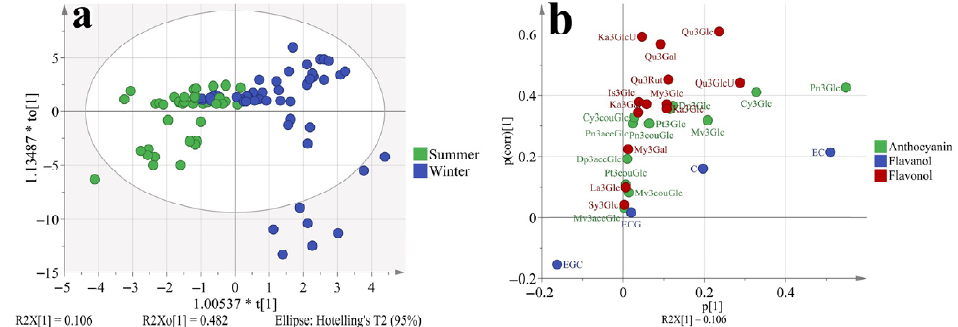
Figure 5. OPLS-DA ( a , score plot; b , S-plot) based on the concentration of individual phenolic compounds in ‘Muscat Hamburg’ grapes and ‘Victoria’ grapes in the years of 2014 and 2015 under the double cropping system. Dp3Glc, delphinidin-3- O -glucoside; Cy3Glc, cyanidin-3- O -glucoside; Pt3Glc, petunidin-3- O -glucoside; Pn3Glc, peonidin-3- O -glucoside; Mv3Glc, malvidin-3- O -glucoside, Dp3aceGlc, Delphinidin-3- O -acetyl-glucoside; Pn3aceGlc, peonidin-3- O -acetylglucoside; Mv3aceGlc, malvidin-3- O -acetyl-glucoside; Cy3couGlc, cyanidin-3- O -coumaryl-glucoside; Pt3couGlc, petunidin-3- O -coumaryl-glucoside; Pn3couGlc, peonidin-3- O -coumaryl-glucoside; Mv3couGlc, malvidin-3- O -coumarylglucoside; My3GlcU, myricetin-3- O -glucuronide; My3Gal, myricetin-3- O -galactoside; My3Glc, myricetin-3- O -glucoside; Qu3Gal, quercetin-3- O -galactoside; Qu3GlcU, quercetin-3- O -glucuronide; Qu3Rut, quercetin-3- O -rutinoside; Qu3Glc, quercetin-3- O -glucoside; La3Glc, laricitrin-3- O -glucoside; Ka3Gal, kaempferol-3- O -galactoside; Ka3GlcU, kaempferol-3- O -glucuronide; Ka3Glc, kaempferol-3- O -glucoside; Is3Glc, isorhamnetin-3- O -glucoside; Sy3Glc, syringetin-3- O -glucoside; ECG, epicatechin-3- O -gallate; EGC, epigallocatechin; C, catechin; EC, Epicatechin.